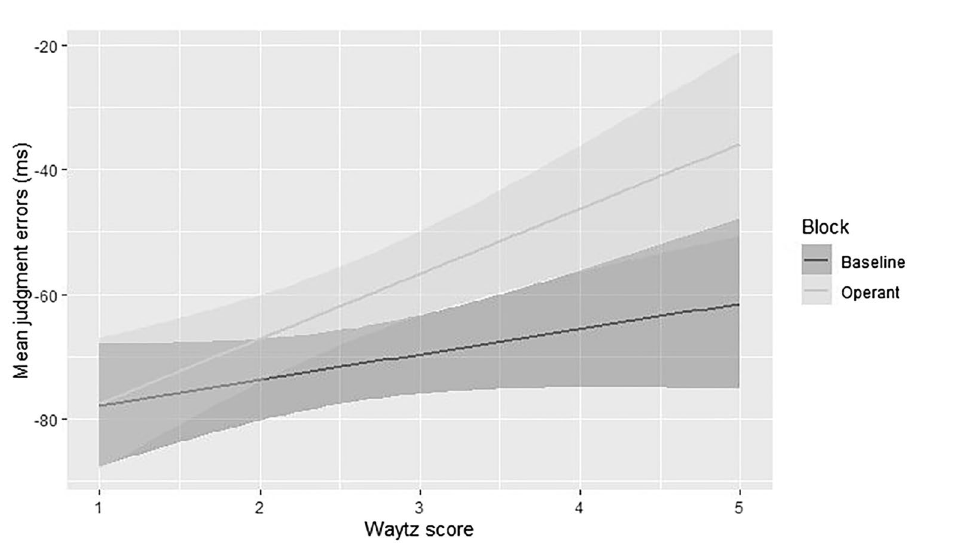
Figure 3. Mean JEs in the Social Context plotted as a function of Waytz score for both Baseline and Operant